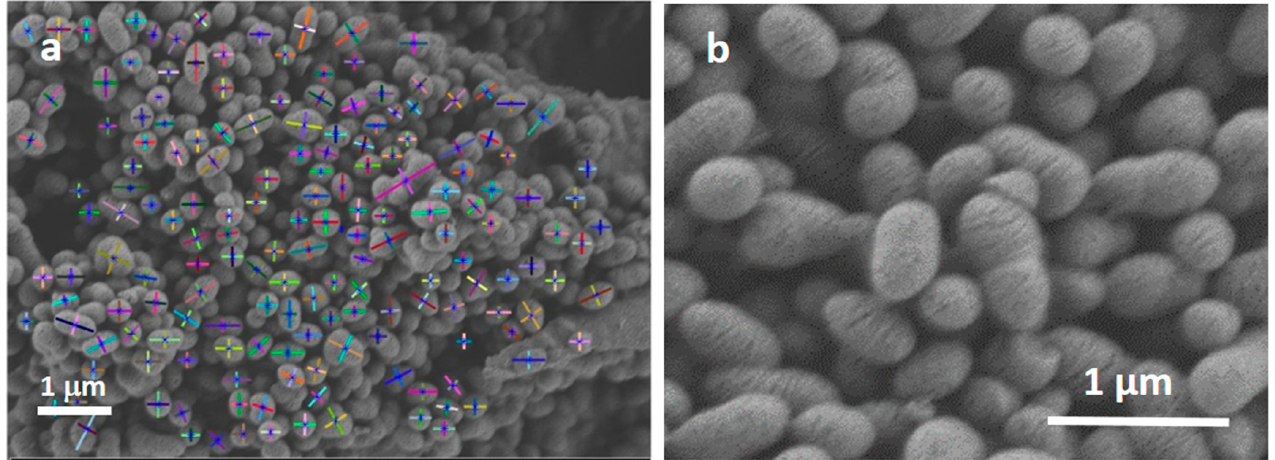
Figure 3. Box-plots of the size distribution of the MBG, MBG EO and MBG EOGe particles. Right, minor diameter; left, major diameter.